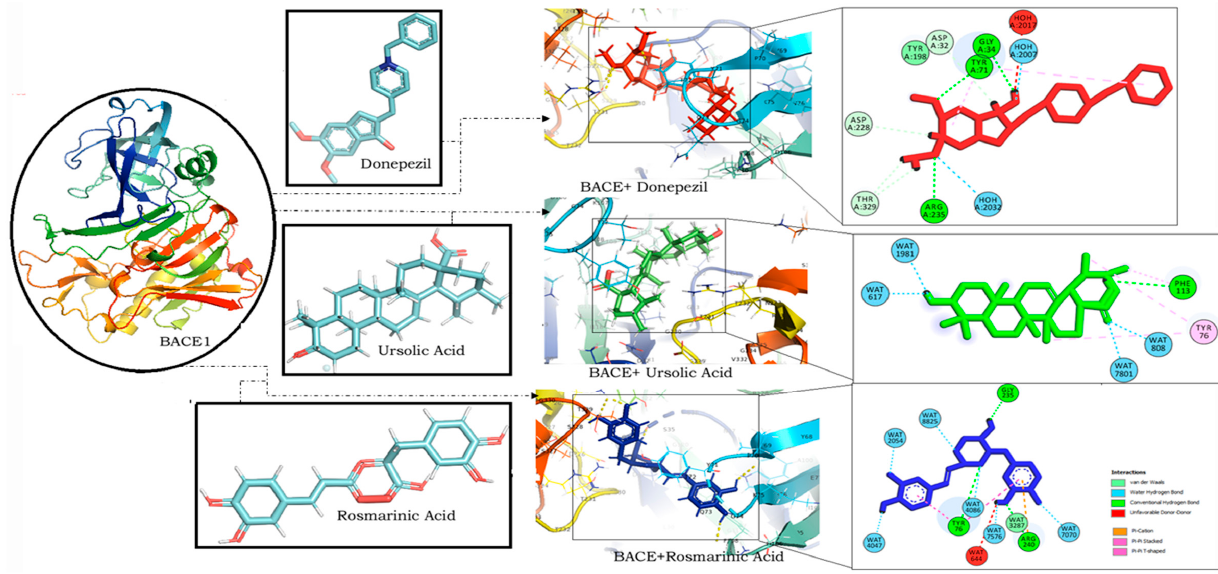
Figure 3. Molecular docking interaction models of BACE 1 (PDB ID: 2WJO) with donepezil, ursolic acid and rosmarinic acid. 2D structures of the compounds are shown by line and stick models with the surrounding amino acids of BACE1. The interactions are denoted by the following colors: hydrogen-bonding interactions (green), alkyl bonds (purple) and bumps (red). BACE1; β -site amyloid precursor protein cleaving enzyme 1.